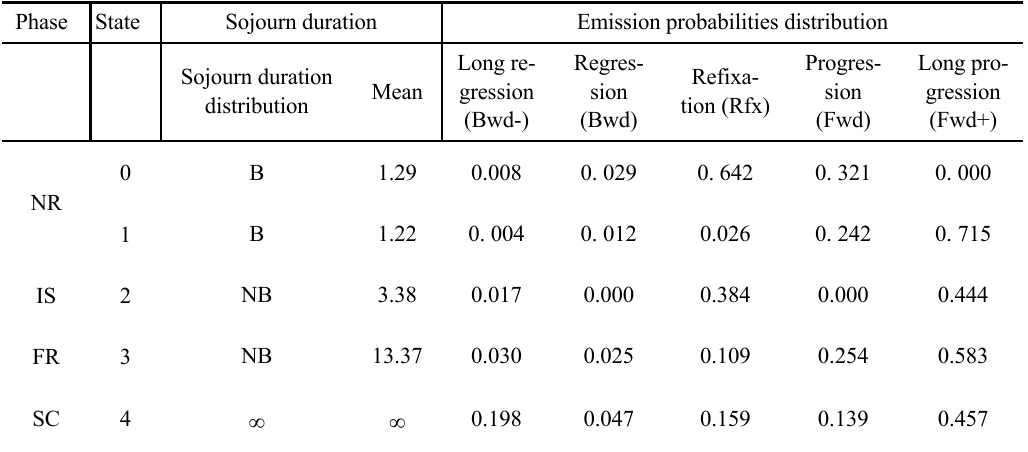
Table 3. HSMC sojourn duration and emission probabilities per state. B is the shifted Binomial distribution and NB is the shifted Negative Binomial distribution. (cid:15459) indicates an absorbing state. Emission probabilities are the probabilities of each possible Read mode value in each state and phase (NR for normal reading, IS for information search, FR for fast reading and SC for slow